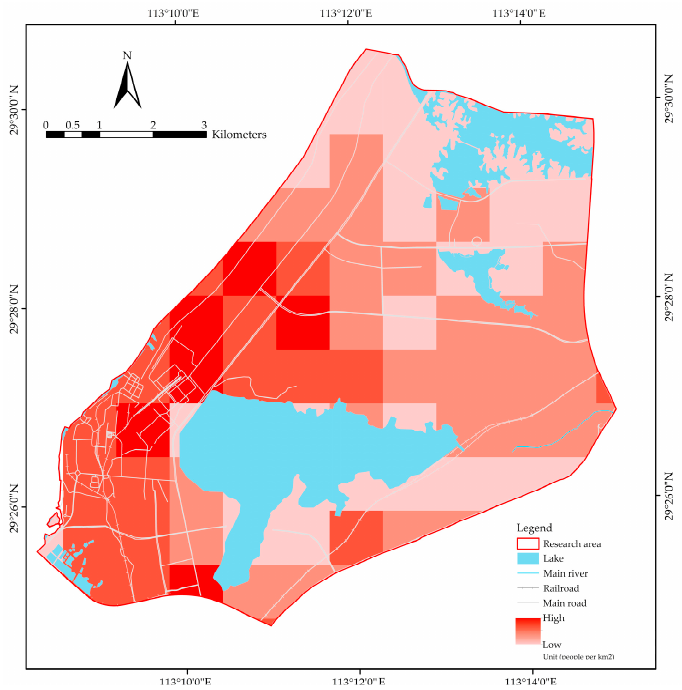
Figure 7. Population density data for the Chenglingji new port area in 2020.